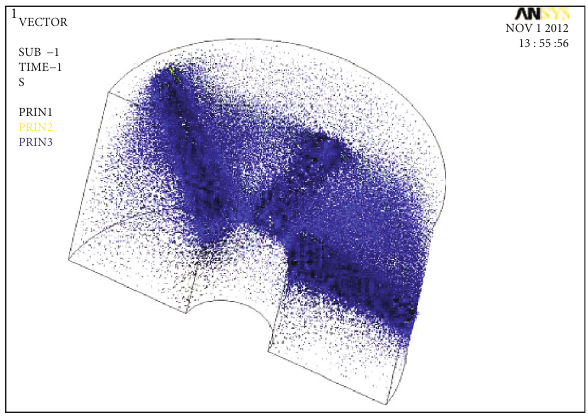
Figure 3: Stress distribution vector map of fi xed-plane perforation.